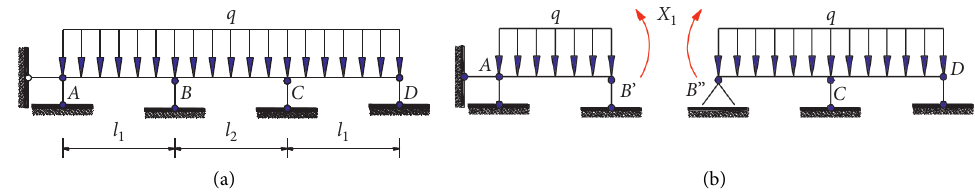
Figure 11: Simplification and calculation of roadway surface layer. (a) Simplified model of roof surface layer. (b) Calculation model of secondary statically indeterminate